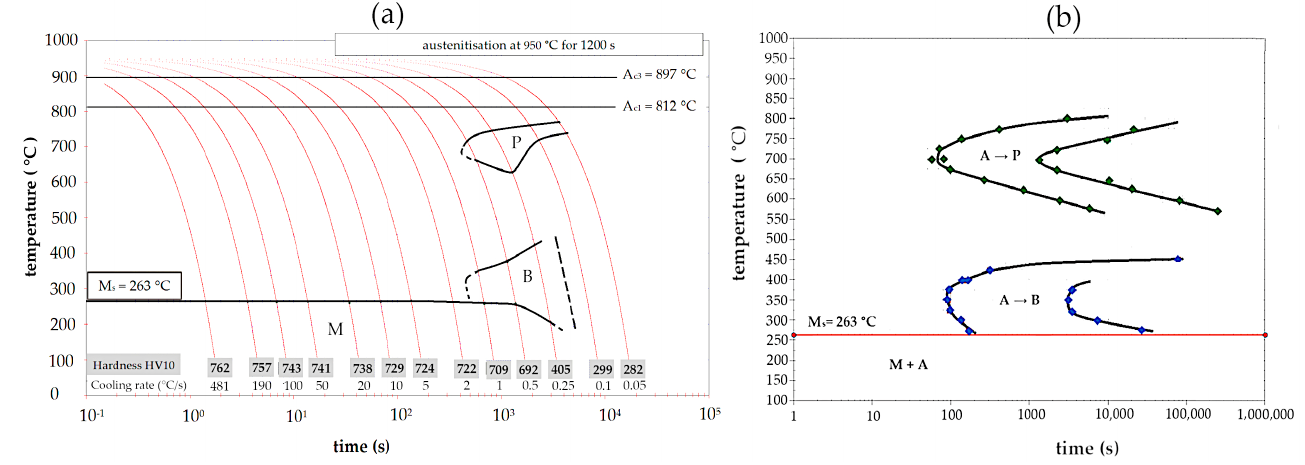
Figure 6. Experimental CCT ( a ) and TTT ( b ) diagrams based on dilatometry. Austenitization was carried out at 950 °C.